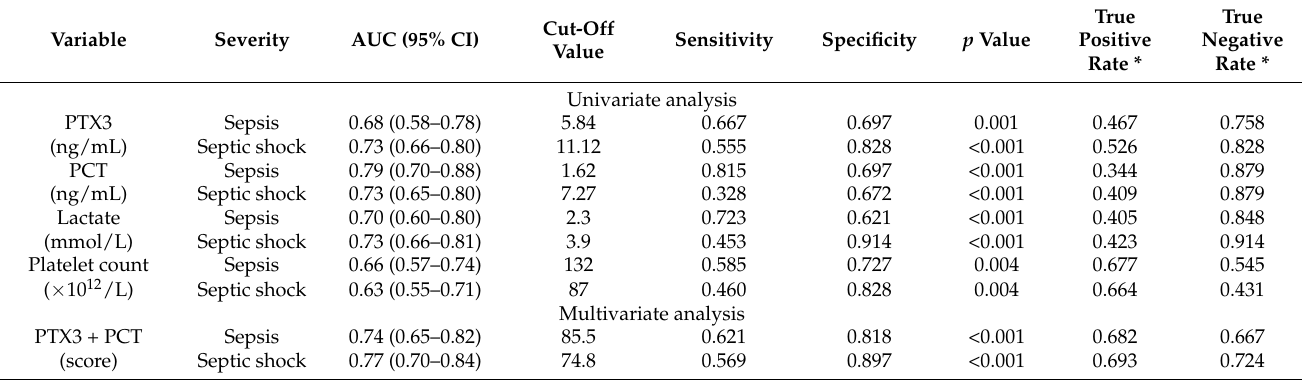
Table 2. Diagnostic value of univariate and multivariate biomarkers for patients with sepsis and septic shock. Variable